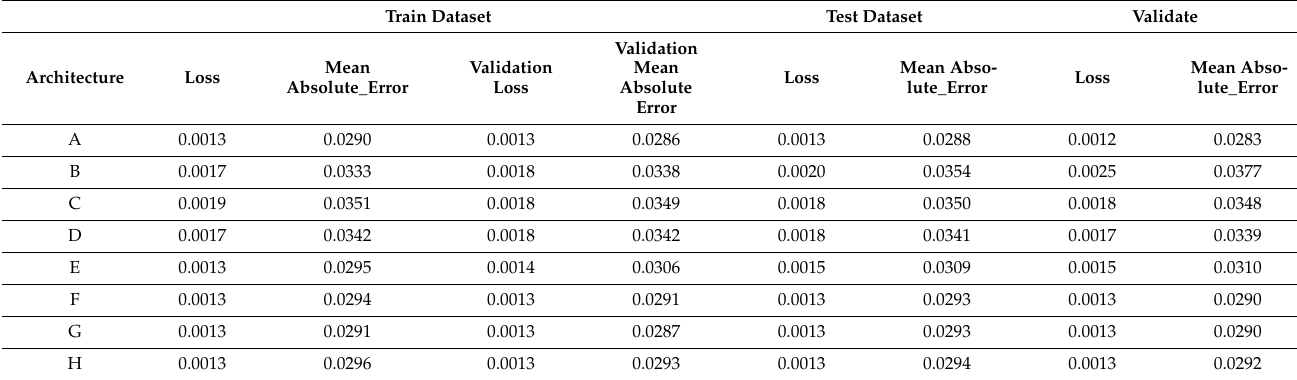
Table 2. Loss and MAE comparison for Extraction network various